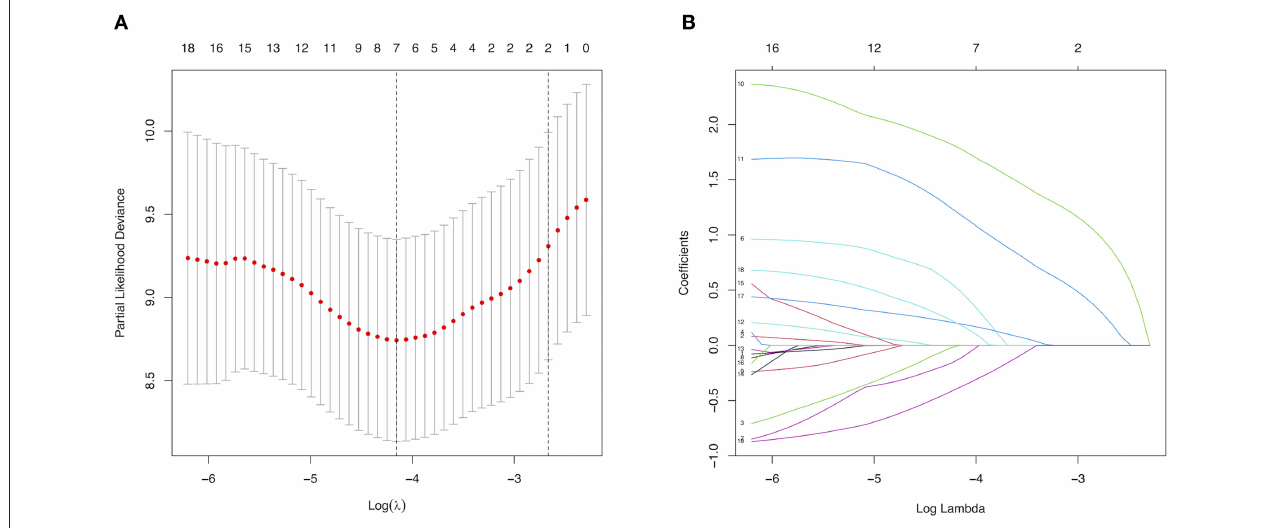
FIGURE 2 | Selection of major risk factors using the least absolute shrinkage and selection operator (LASSO) binary logistic regression model. (A) Tuning parameter ( λ ) selection in the LASSO model used 5-fold cross-validation via minimum criteria. The partial likelihood deviance (binomial deviance) curve was plotted vs. log( λ ). Dotted vertical lines were drawn at the optimal values using the minimum criteria and the 1 standard error of the minimum criteria (the 1-SE criteria). (B) LASSO coefficient profiles of the 19 predictors. A coefficient profile plot was produced against the log( λ ) sequence. A vertical line was drawn at the value selected using 5-fold cross-validation, where the optimal λ resulted in 6 non-zero